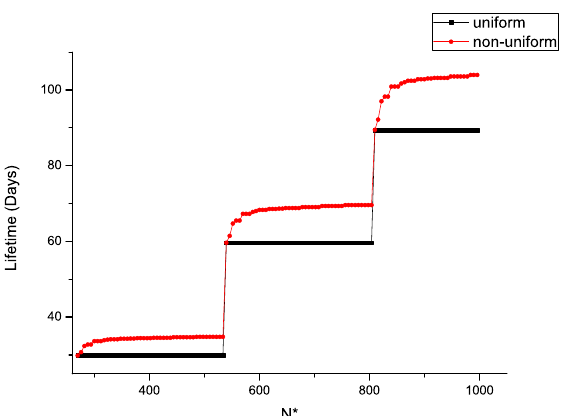
Figure 5. Optimal lifetime under different N ∗